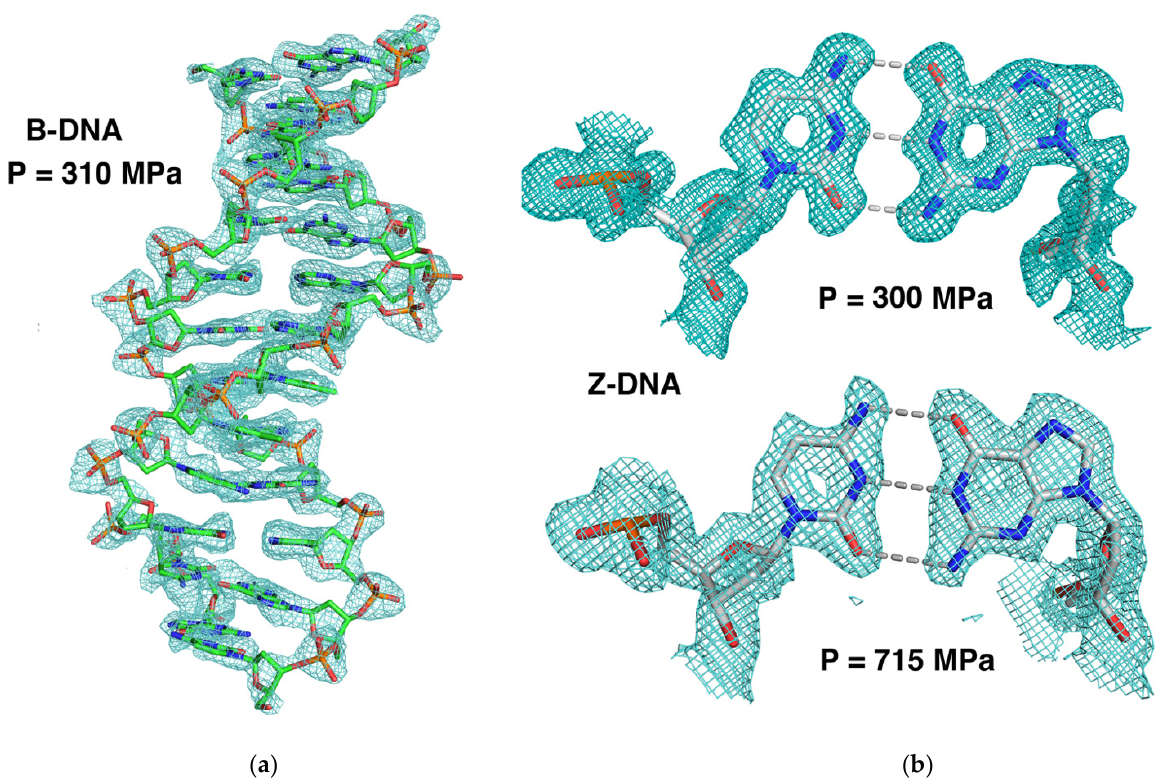
Figure 5. Electron densities of ( a ) B-DNA at 310 MPa (side view) and ( b ) the Z-DNA C3-G10 base- pair along the helix axis at 300 and 715 MPa. The map contouring is at the 1.5 σ level. along the helix axis at 300 and 715 MPa. The map contouring is at the 1.5 σ